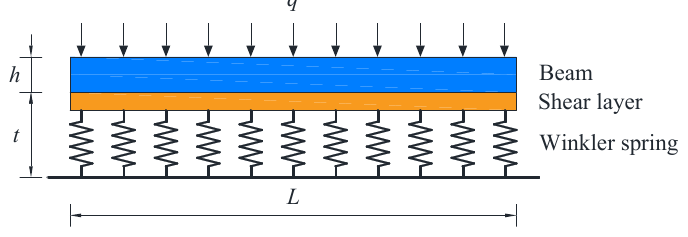
Figure 4. Soil–building interaction model.